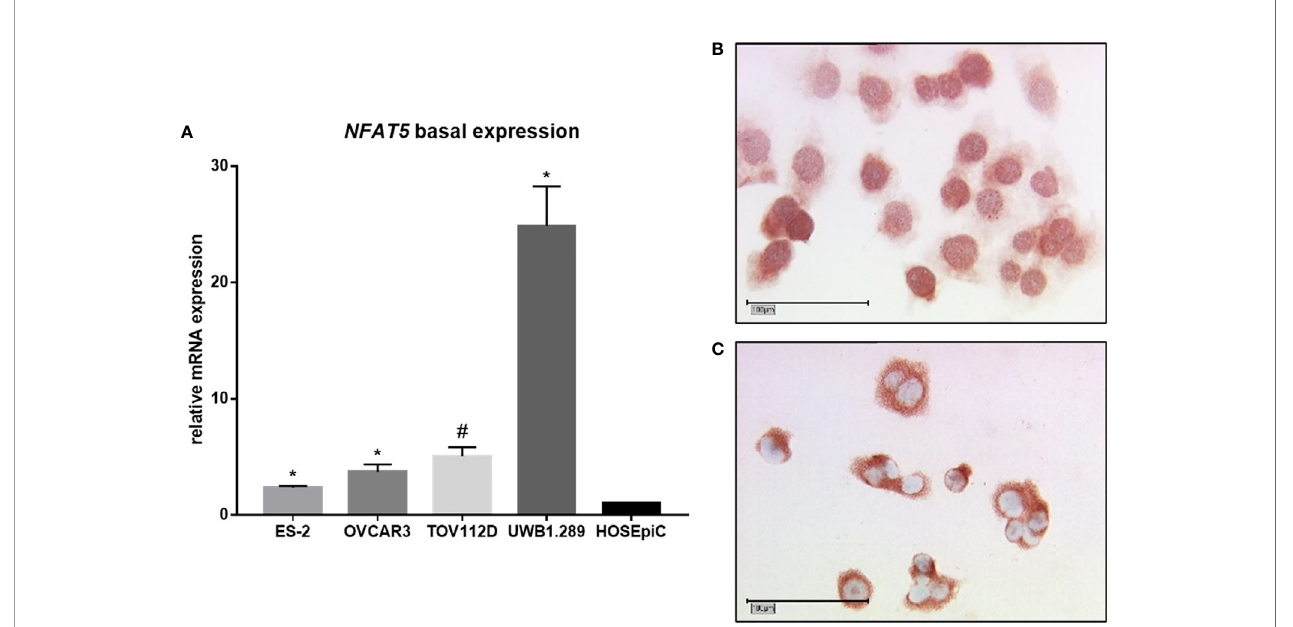
FIGURE 4 | Basal expression of NFAT5 in ovarian cancer cell lines. (A) qPCR results showing NFAT5 expression in four EOC cell lines (ES-2, OVCAR3, TOV112D, UWB1.289) compared to the benign control cell line (HOSEpiC; n=6; * p =0.028; # p =0.027). (B, C) Detection of NFAT5 in UWB1.289 cells by immunocytochemistry. Exemplary photographs (25x magni fi cation; scale bar=100µm) showing protein expression in both nucleus (B) and cytoplasm (C)